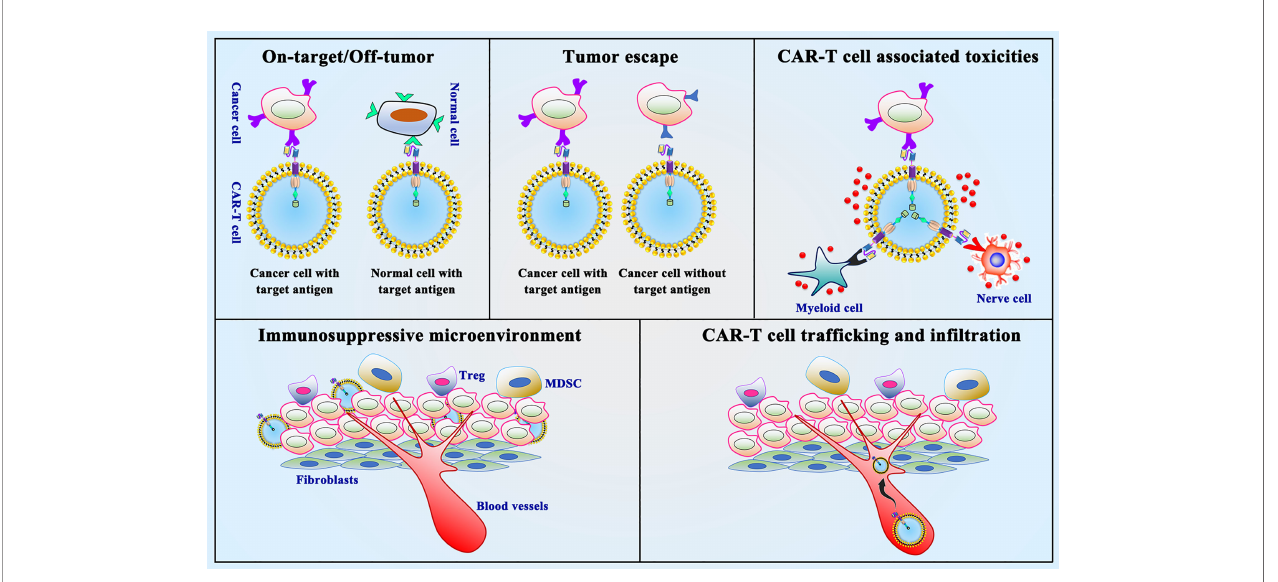
FIGURE 4 | Limitations and challenges of CAR-T cell therapy. On-target/off-tumor toxicity, tumor antigen escape, neurological toxicity, immunosuppressive microenvironment and CAR-T cell traf fi cking and tumor in fi ltration are the presented limitations and challenges in CAR-T cell